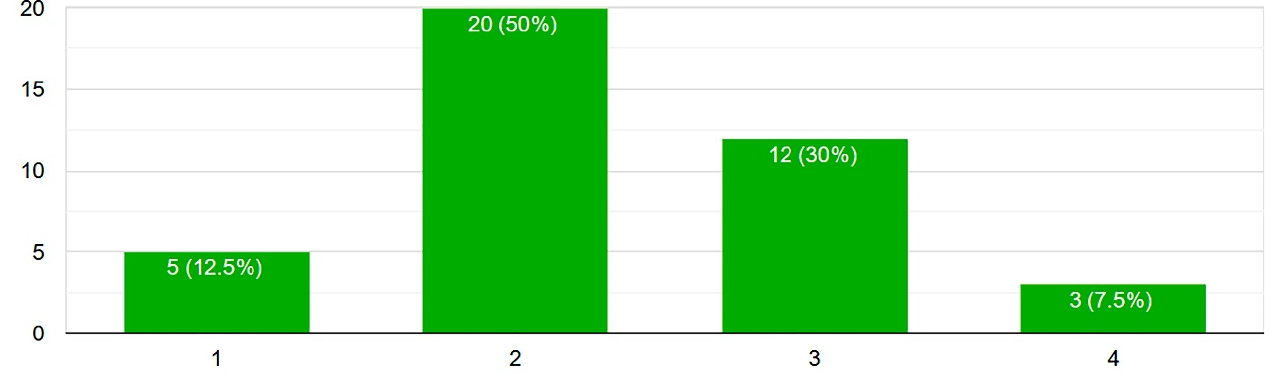
Figure 12. Knowledge of SDGs.